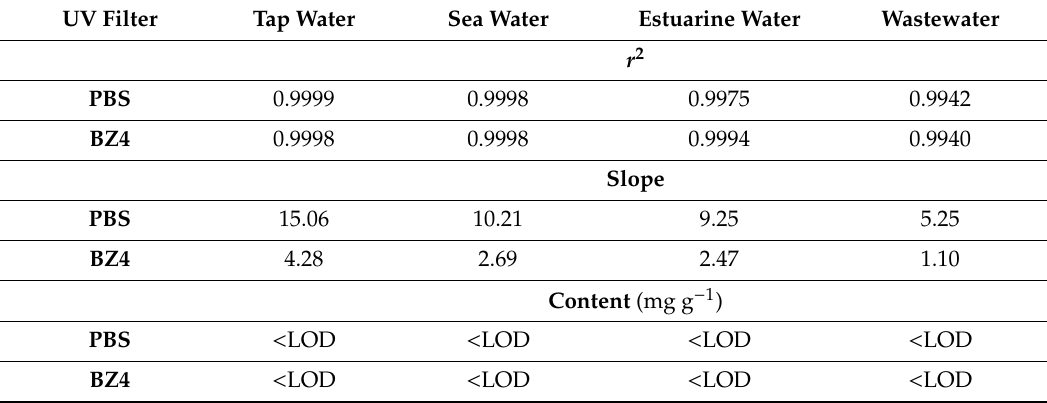
Table 3. Determination coe ffi cients ( r 2 ), slopes, and contents obtained for the two UV filters by BA µ E(PS-DVB)- µ LD / HPLC–DAD in several real matrices, under optimized experimental